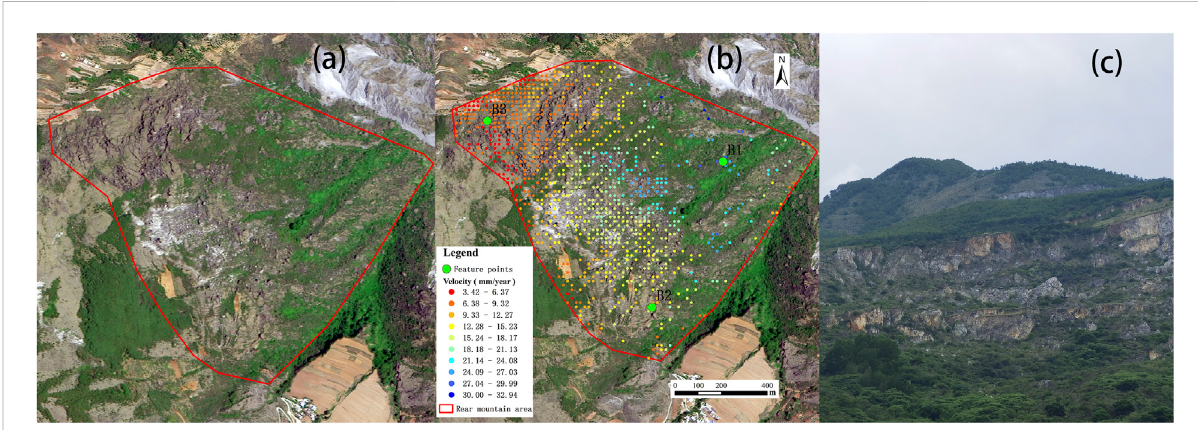
FIGURE 11 Remotesensingimageandtimeseriesdeformationmonitoringresultsoftherearmountain. (A) Opticalremotesensingimage; (B) Deformation velocity; (C) Field investigation picture.